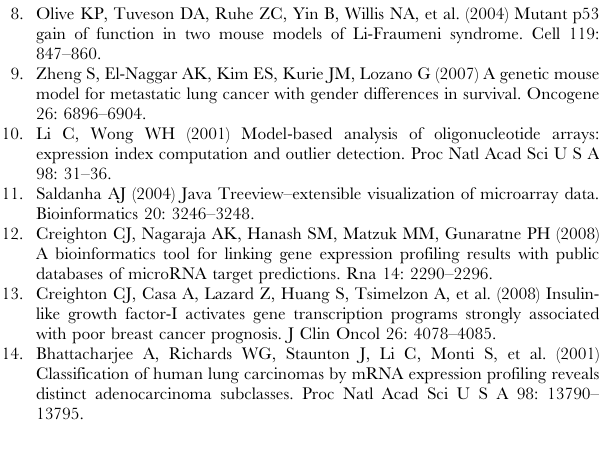
Figure S3 PDF describing ‘‘Impact of cell cycle genes on progression-free survival and overall survival’’ Found at: doi:10.1371/journal.pone.0005401.s003 (0.08 MB PDF) Figure S4 PDF describing ‘‘Comparison of mouse metastasis signature with other metastasis signatures’’ Found at: doi:10.1371/journal.pone.0005401.s004 (0.27